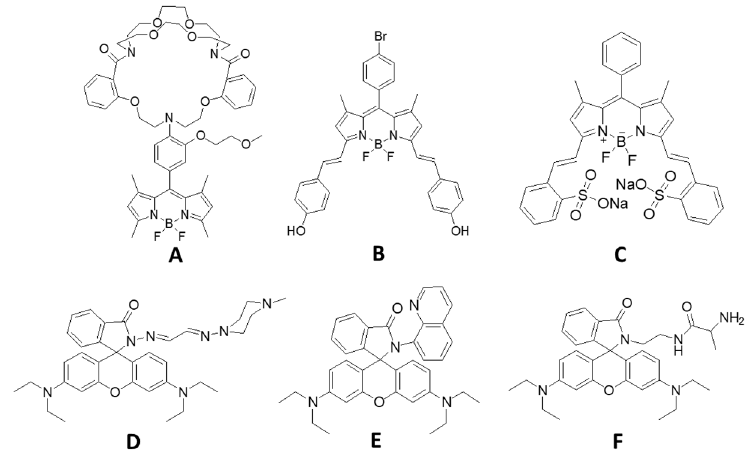
Figure 9. Structures of BODIPY- and rhodamine-based Fe 3+ sensors in the literature. The effect of pH toward photophysical properties of BODIPY-PH (10 µM) with and